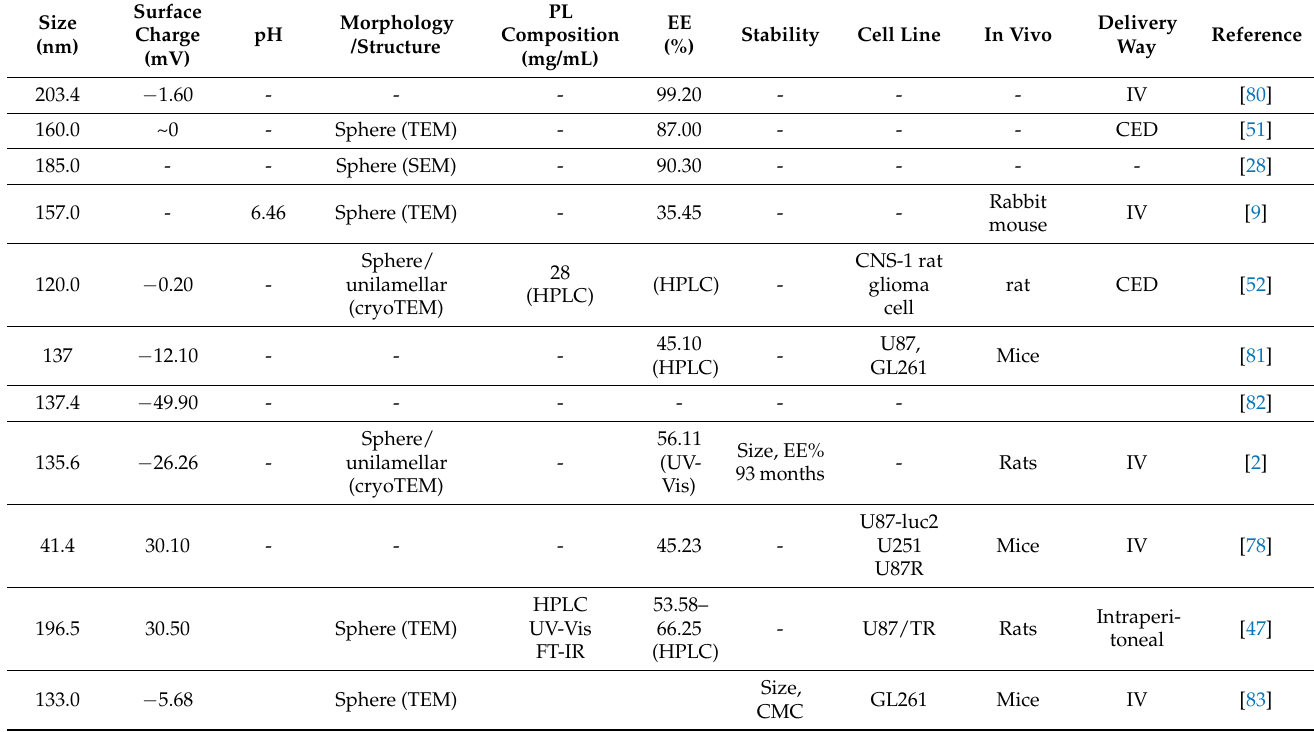
Table 2. Physico-chemical properties investigated in papers discussed in this